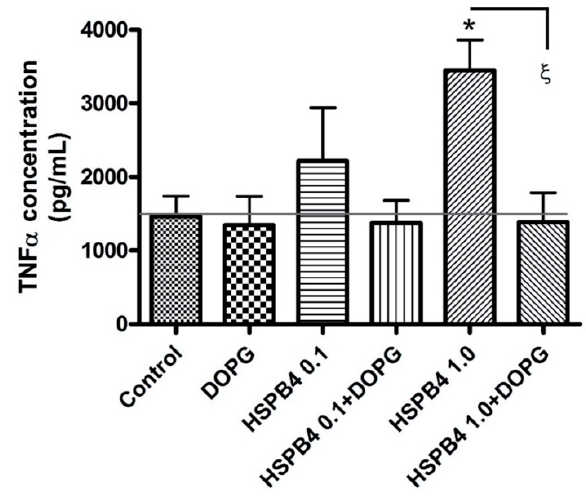
Figure 2. DOPG inhibited TNF α protein production in a macrophage cell line stimulated with recombinant HSPB4. RAW264.7 cells were treated with 0, 0.1, or 1 µg/mL HSPB4 in the presence or absence of 100 µg/mL DOPG for 2 h. ELISA was used to assess TNF α levels (pg/mL) in media collected from the treated cells. Experiments were performed on three separate occasions, with the results shown representing the means ± standard error of the mean. * p < 0.05 versus control; ξ p < 0.05 as indicated, using ANOVA with Tukey’s post-hoc testing. DOPG, dioleoylphosphatidyl- glycerol; HSPB4, heat shock protein B4; TNF α , tumor necrosis factor- α